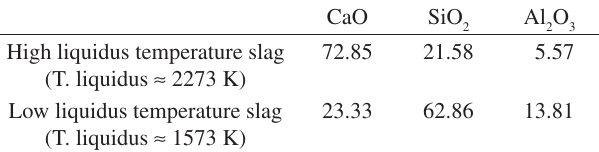
Table 2. Calculated composition of the high and low liquidus temperature slags, weight %. High liquidus temperature